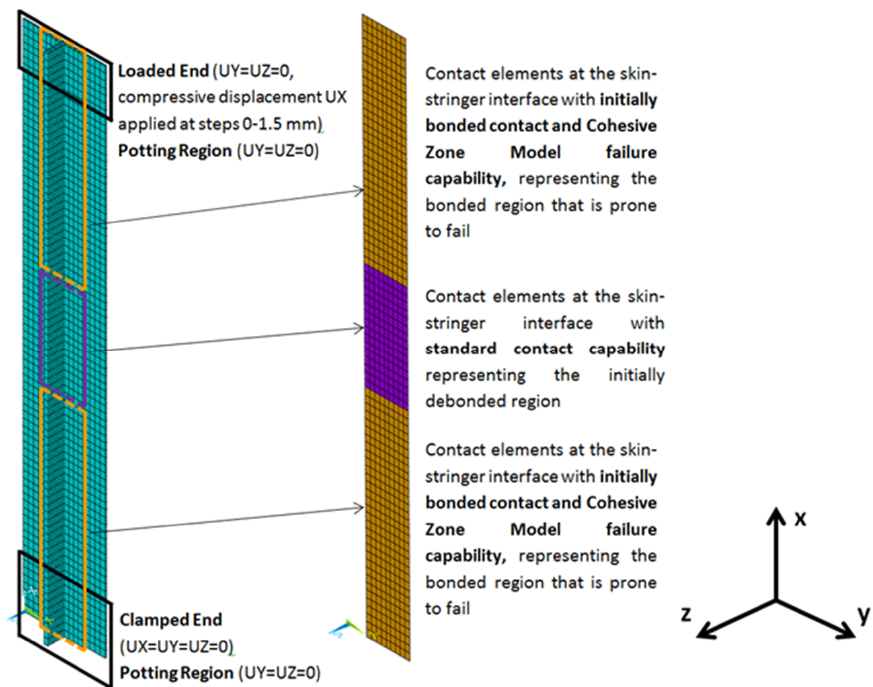
Figure 2. Typical FE model of the studied SSCS.